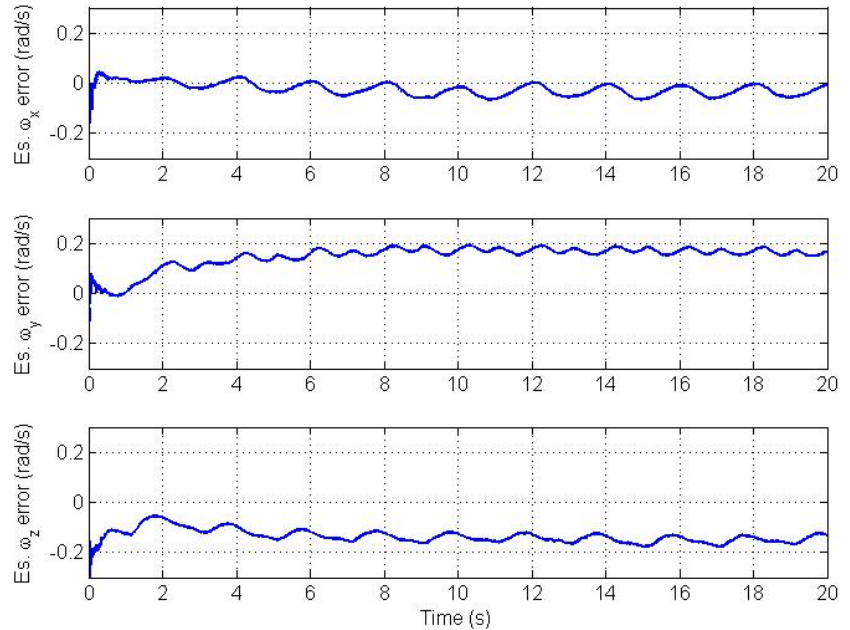
Figure 11. Angular velocity vector estimation errors for the reduced model with large AIV bias